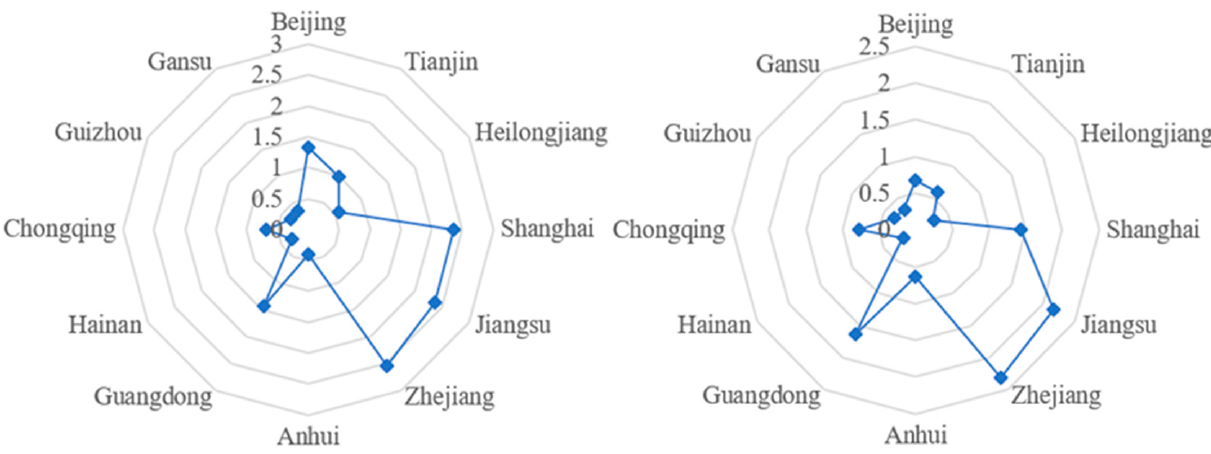
Figure 5. The MAGG trends of selected provinces (autonomous regions and municipalities) in 2010 and